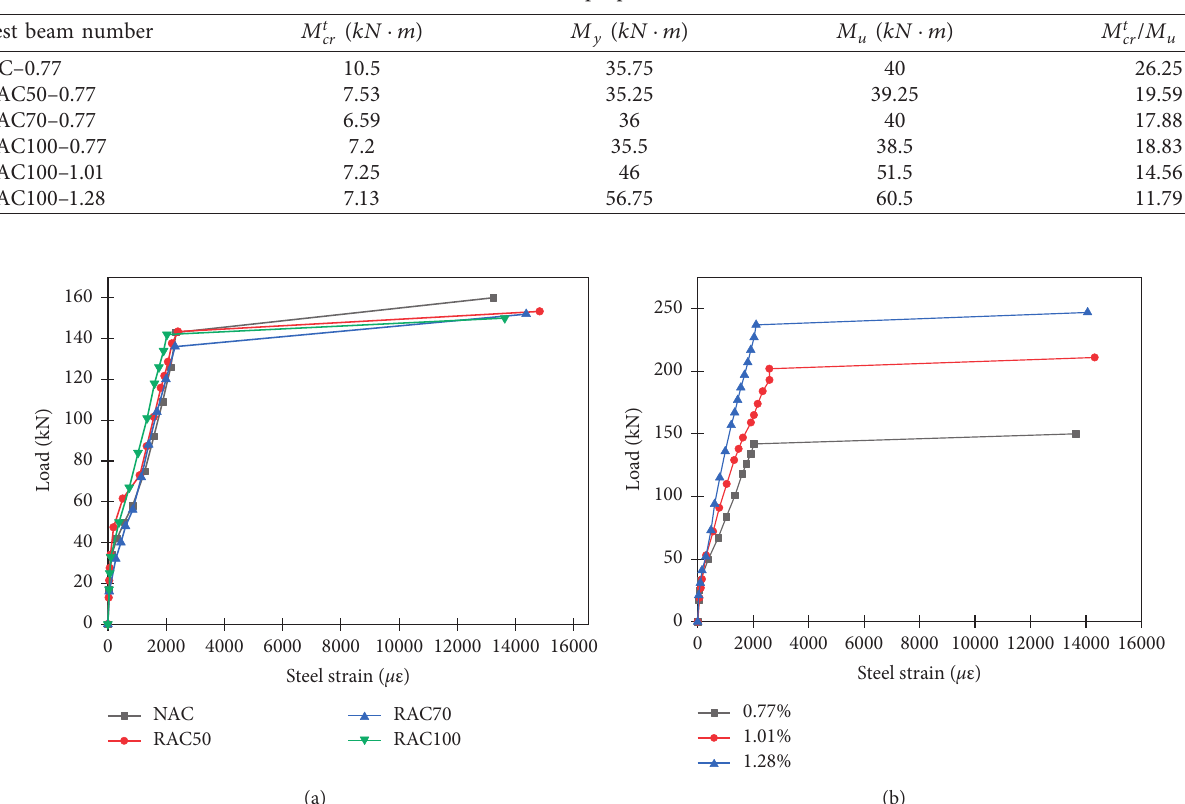
Figure 5: Load-mid-span deflection curves. (a) Substitution ratio of RCA. (b) Reinforcement ratio of tensile reinforcement. Table 7: Mechanical properties of test beams.